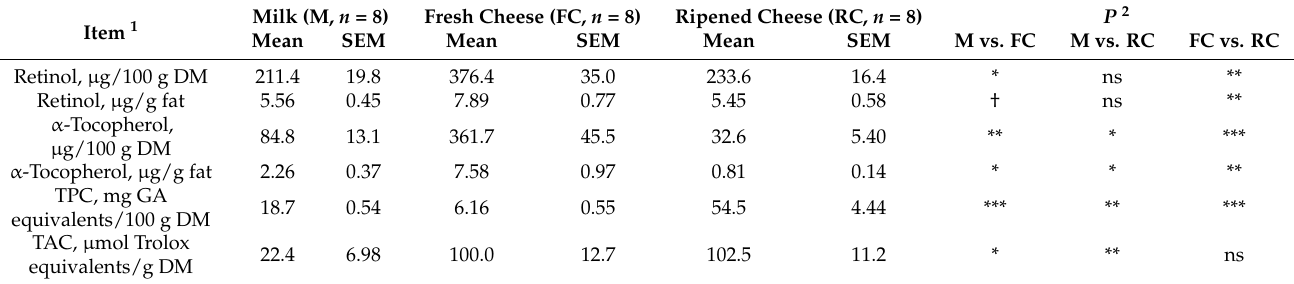
Table 3. Fat-soluble vitamins, phenolic compounds, and total antioxidant capacity of fresh and ripened Roja Mallorquina ewes’ cheese and corresponding original